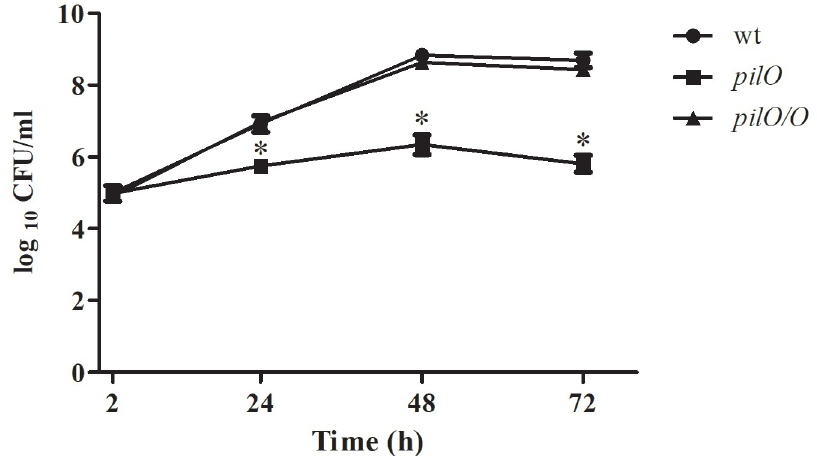
Fig 4. Growth kinetics of the pilO mutant within HMDMs. Cells were infected with wt F . novicida , the pilO mutant and the complemented strain at MOI of 100. Growth kinetics was determined at 2, 24, 48 and 72 h after infection. Extracellular bacteria were removed by washing. The error bars represent standard deviations of three independent biological replicates. Asterisks denote that the growth kinectics of the pilO mutant is statistically different from that of wt F . novicida , as determined by Student t- test ( � , p < 0.05).